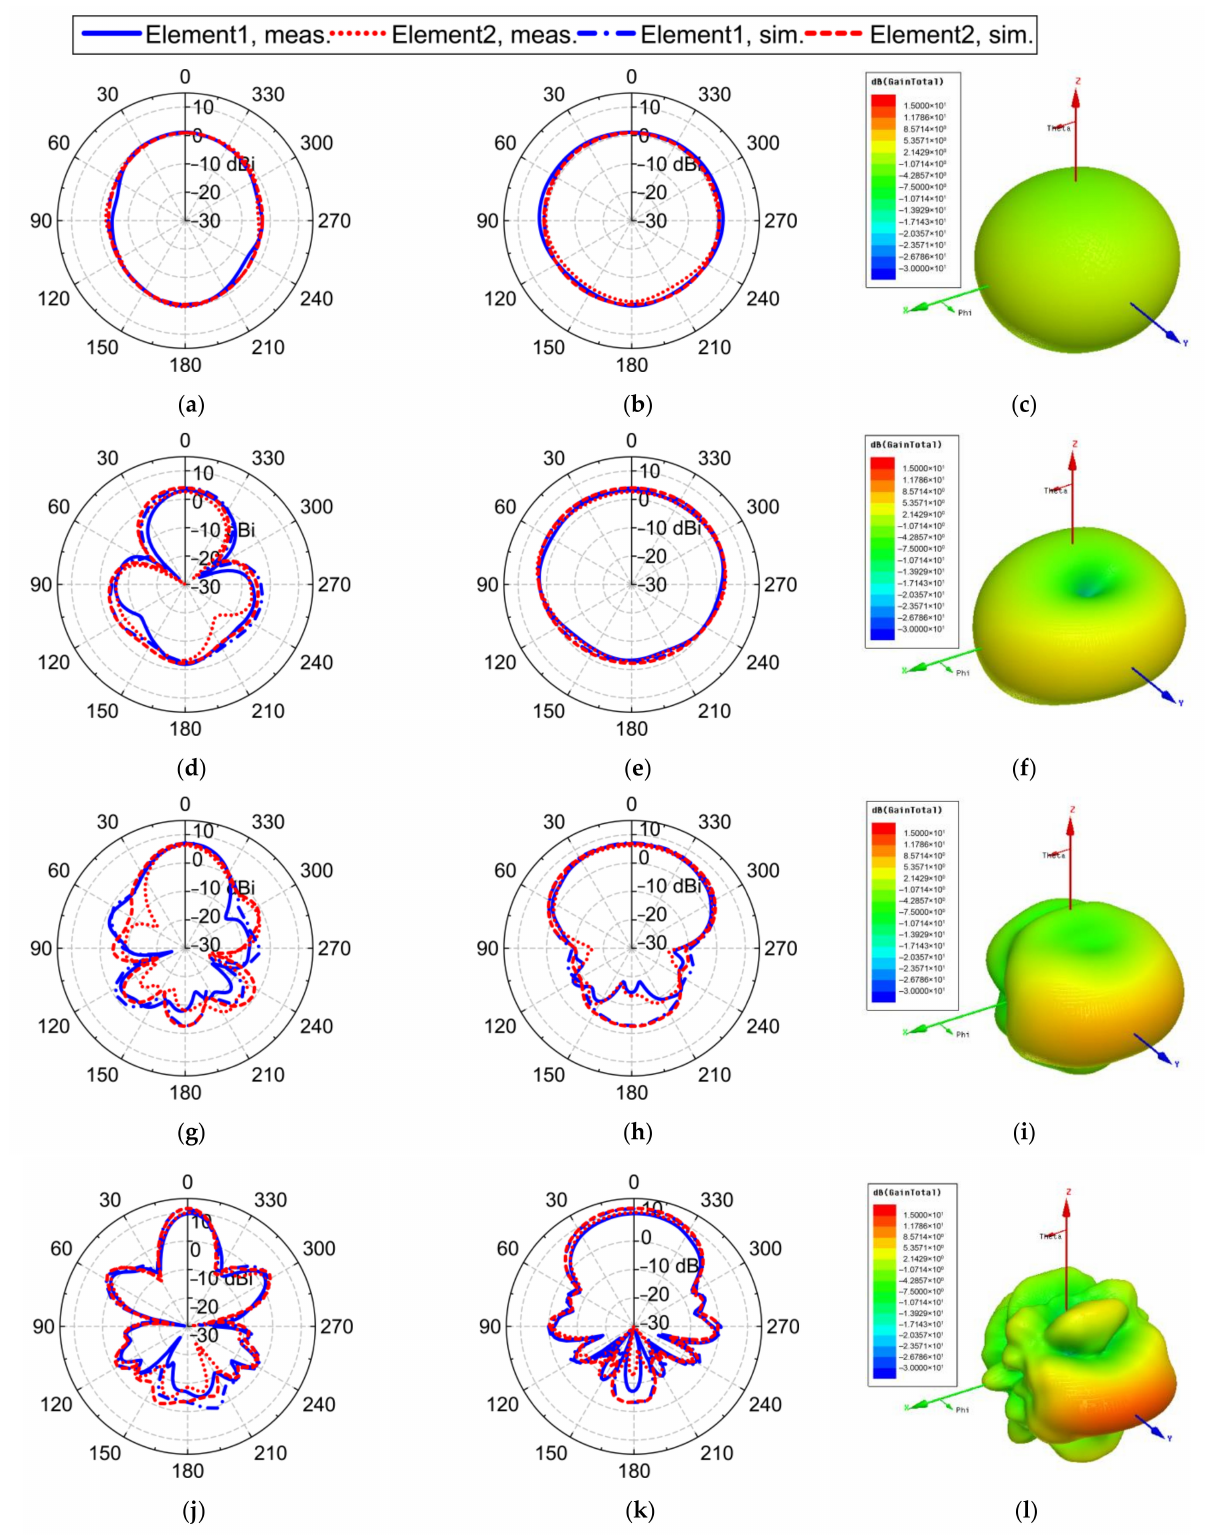
Figure 9. The simulated and measured gain patterns of the proposed elements in the DP-DSATSA. ( a ) E-plane patterns at 0.6 GHz; ( b ) H-plane patterns at 0.6 GHz; ( c ) 3D pattern at 0.6 GHz; ( d ) E-plane patterns at 1 GHz; ( e ) H-plane patterns at 1 GHz; ( f ) 3D pattern at 1 GHz; ( g ) E-plane patterns at 2 GHz; ( h ) H-plane patterns at 2 GHz; ( i ) 3D pattern at 2 GHz; ( j ) E-plane patterns at 4 GHz; ( k ) H-plane patterns at 4 GHz; ( l ) 3D pattern at 4